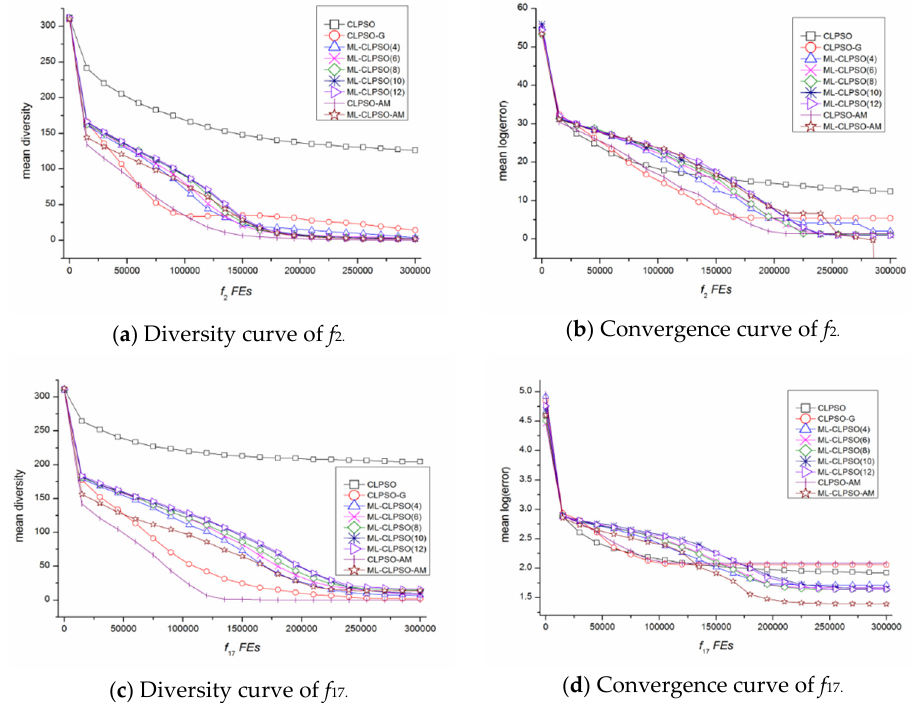
Figure 1. The diversity curve and convergence curve of ML-CLPSOs.